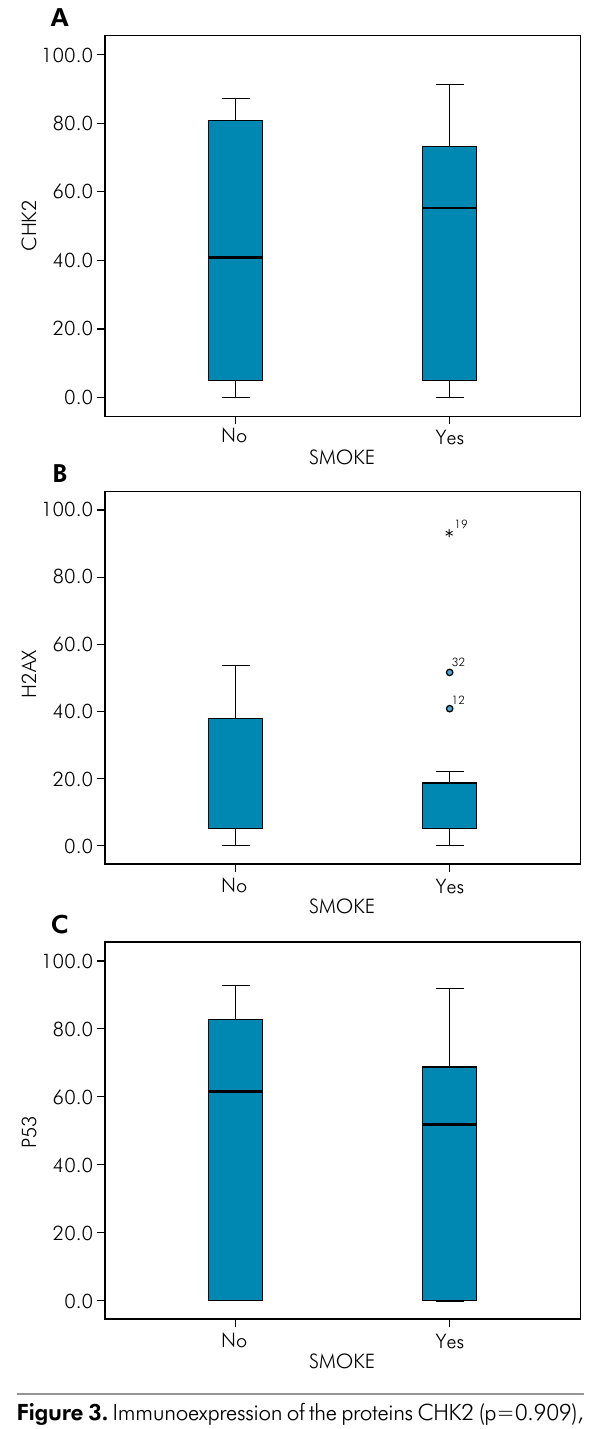
Figure 3. Immunoexpression of the proteins CHK2 (p=0.909), H2AX (p = 0.807) and P53 (p = 0.546) between smokers and